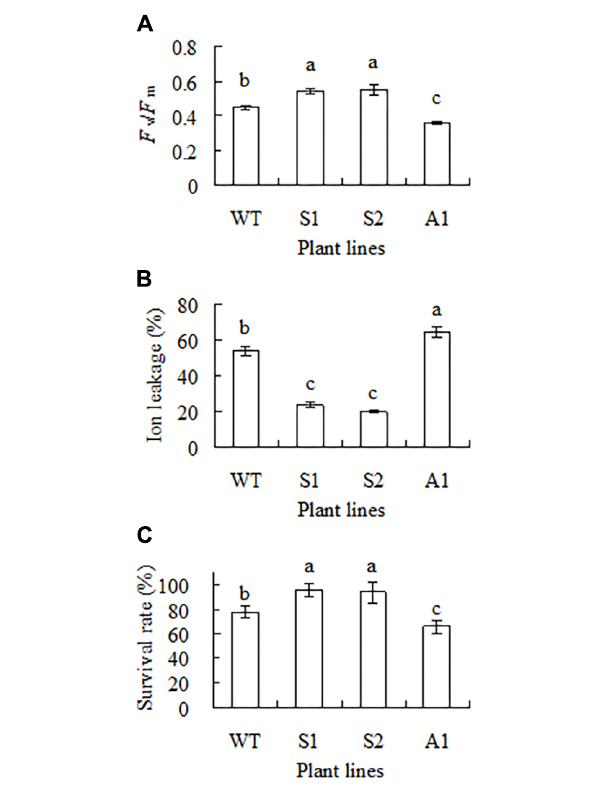
FIGURE 5 | Analysis of chilling tolerance in transgenic plants overexpressing SgCP12 or down-regulating SgCP12 expression in comparison with the wild type ( S . guianensis cv. CIAT184). F v / F m (A) and ion leakage (B) were measured 8 d after chilling treatment at 6 ◦ C, while survival rate (C) was measured after 7 d of recovery at room temperature post chilling treatment. Means of three replicates and standard errors are presented; the same letter above the column indicates no significant difference at P < 0.05.